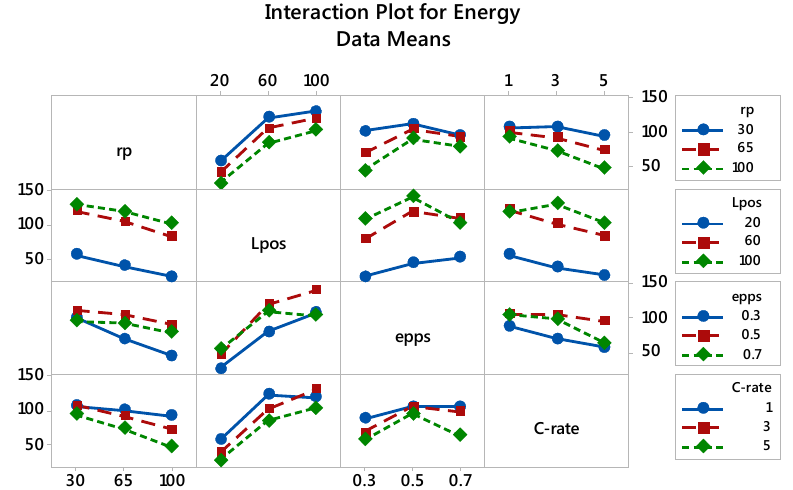
Figure 5. Interaction effect of design parameters, particle size ( r p ), electrode thickness ( L pos ), volume fraction of the active material ( ε s , pos ) and (C-rate) at different levels on the specific